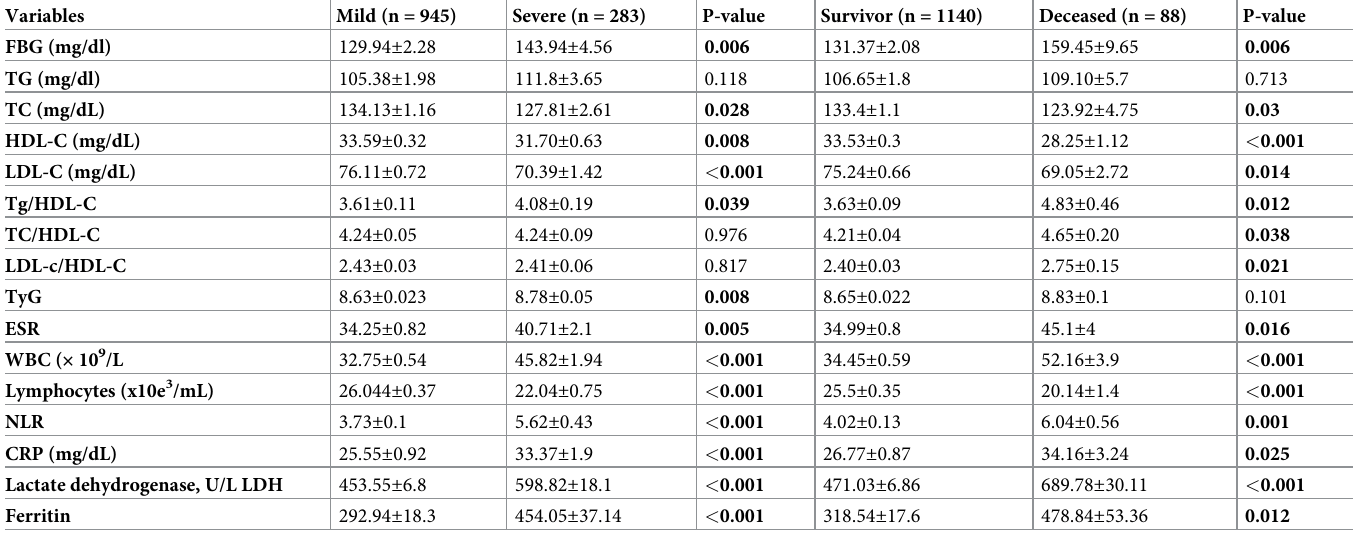
Table 2. Laboratory findings, Lipid profile and lipid ratios of patients with